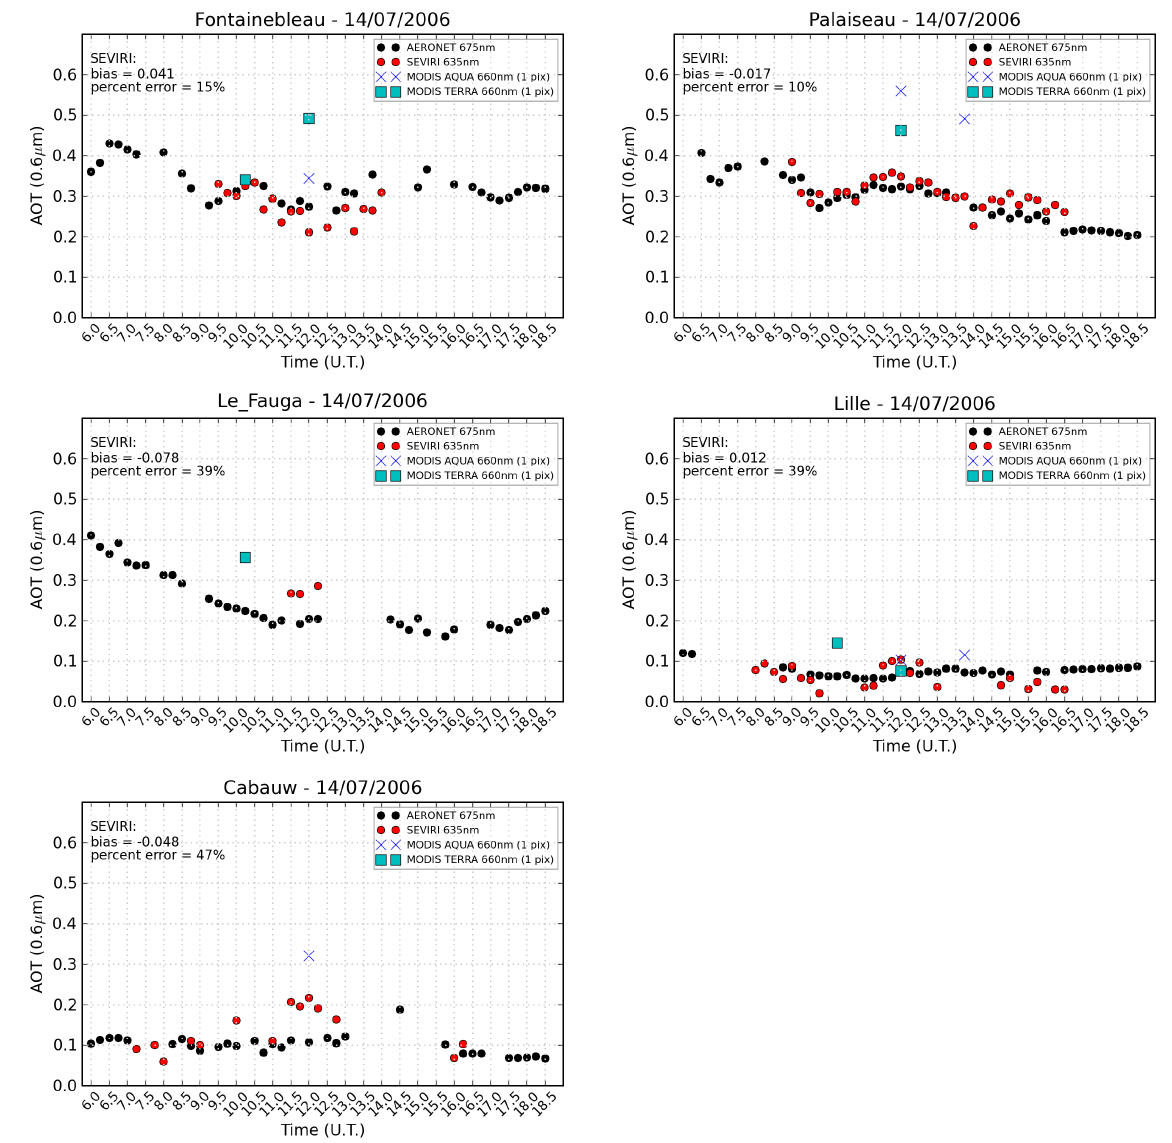
Fig. 9. Temporal evolution of the aerosol optical thickness above Fontainebleau, Palaiseau, Le Fauga (near Toulouse), Lille and Cabauw for the 14 July 2006. The black dots are AERONET, the red dots are SEVIRI and the blue crosses and cyan squares are for MODIS AQUA and TERRA at 660nm. The mean bias and the mean relative bias between AERONET and SEVIRI are indicated on each plot. The SEVIRI and MODIS pixels are the ones geolocated with the AERONET station. The time scale is from 6:00 to 18:45 UTC and the AOT scale is from 0 to 0.7.